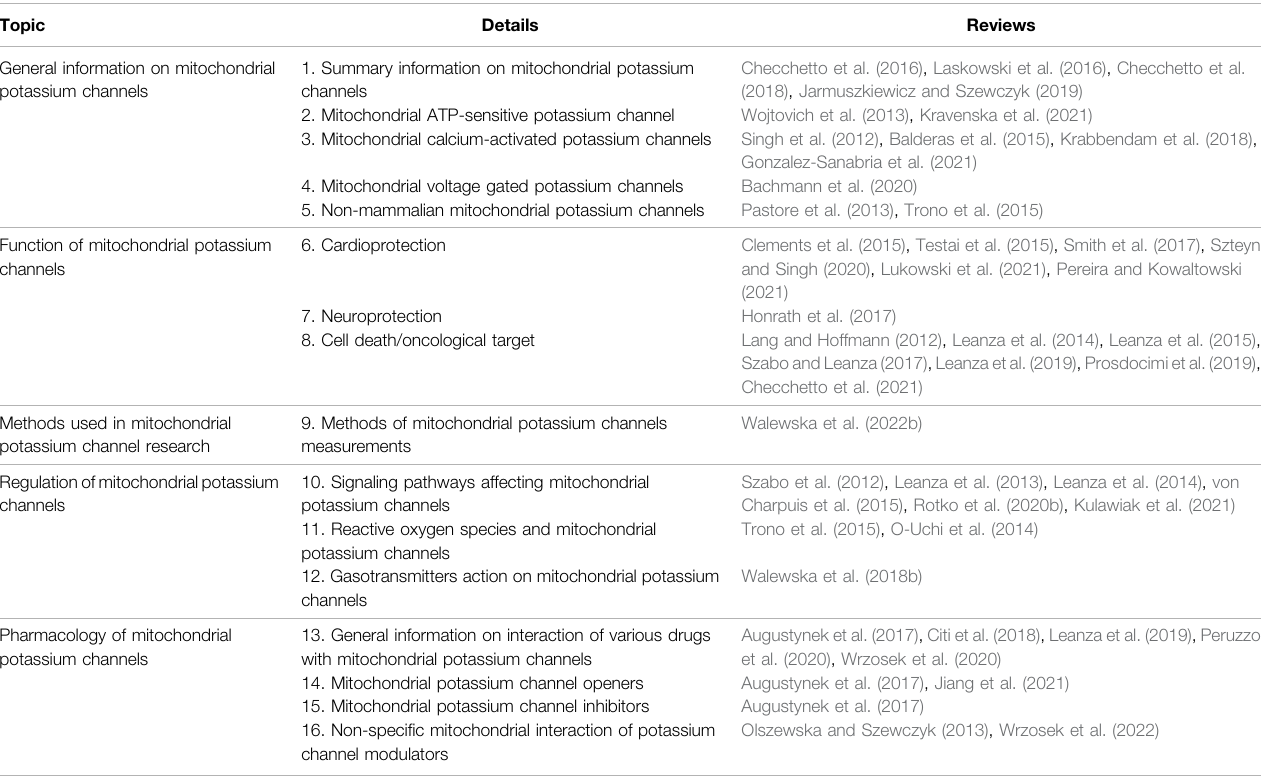
TABLE 1 | Review papers on mitochondrial potassium channels published since 2012 till